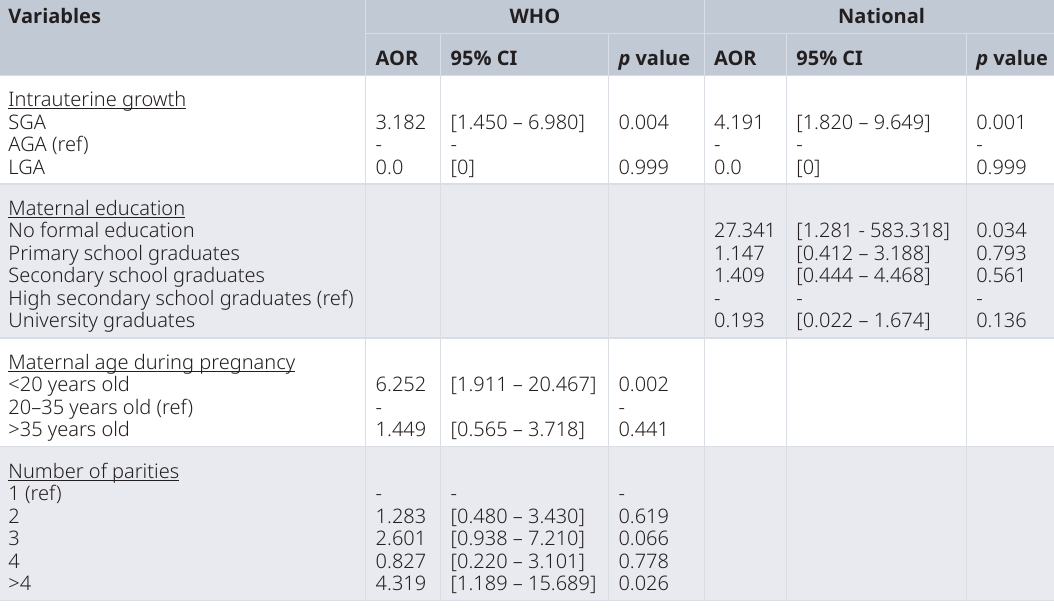
Table 6. Multivariate analysis of determinants for underweight among children aged 0–59 months in Musi Sub-district.